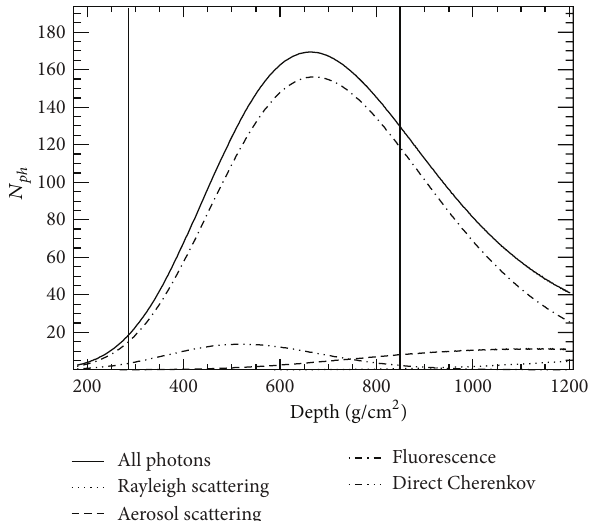
Figure 4: Profiles of all photons along with the shower longitudinal development that were produced by a shower in simulation. The solid curve represents the sum of all photons. The short-dot- dashed curve represents fluorescence photons. The long-dot-dashed curve represents direct Cherenkov components. The dashed curve represents Cherenkov photons scattered by aerosols. The lowest dot- ted curve represents Cherenkov photons scattered by atmospheric molecules (Rayleigh scattering). The range between two vertical lines is covered by